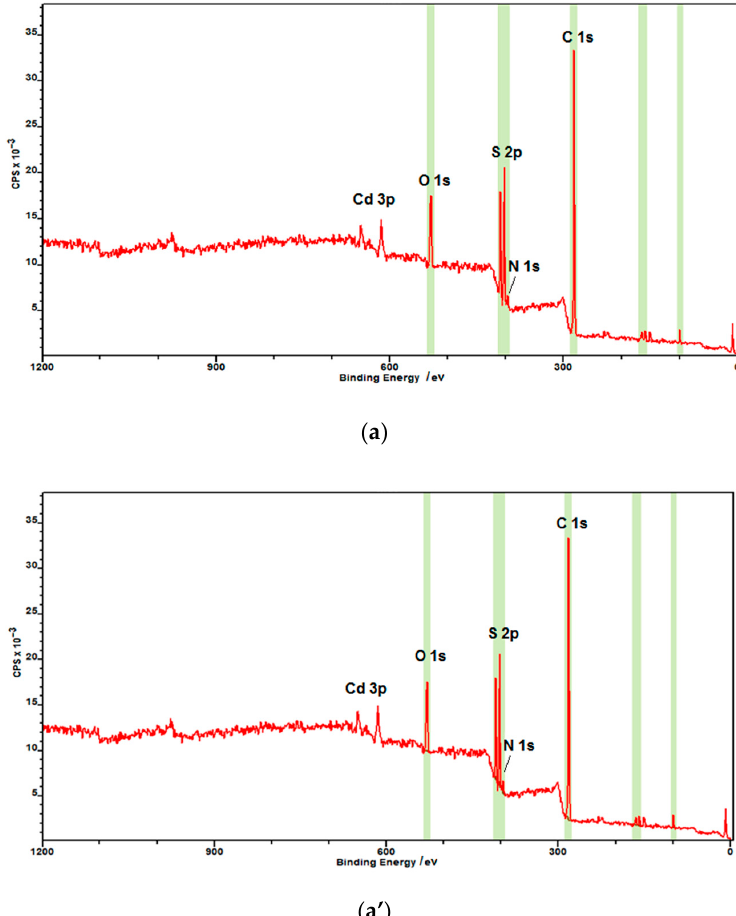
Figure 2. Powder X-ray di ff raction pattern of as synthesized CdS crystalline hydrophilic nanoparticles with assigned hkl indices.